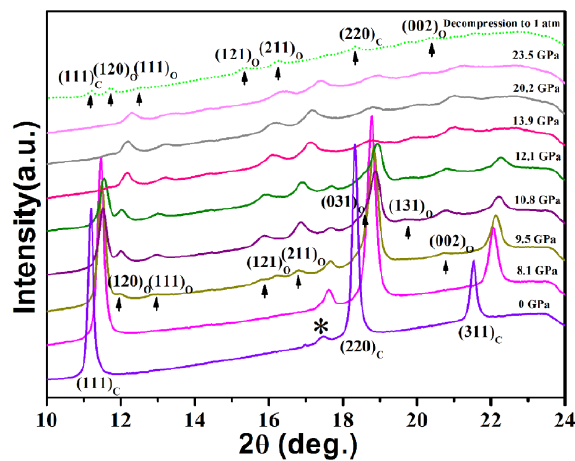
Figure 2. High-pressure X-ray diffraction patterns of CaF 2 nanocrystals. Upon being completely quenched to the ambient conditions. The peak (marked with asterisk) is derived from the T301 stainless steel gasket.